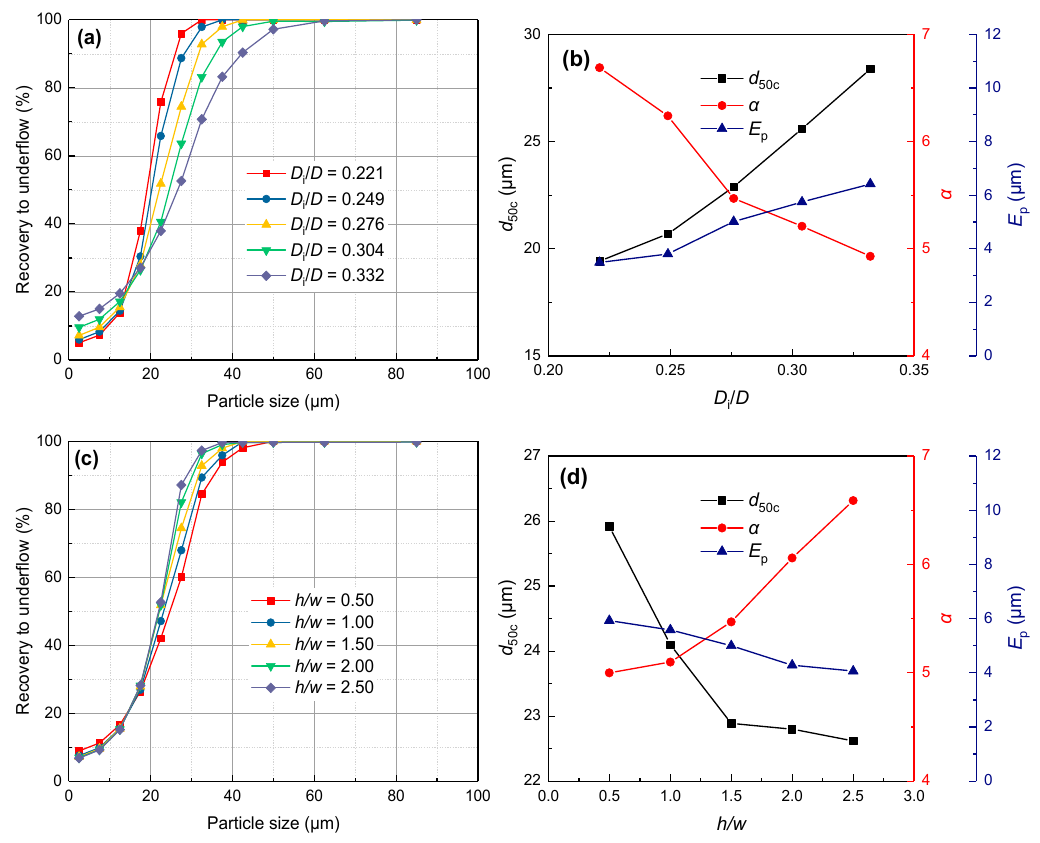
Figure 9. Effects of inlet structure on separation performance. ( a , b )-D i /D; ( c , d )-h/w.